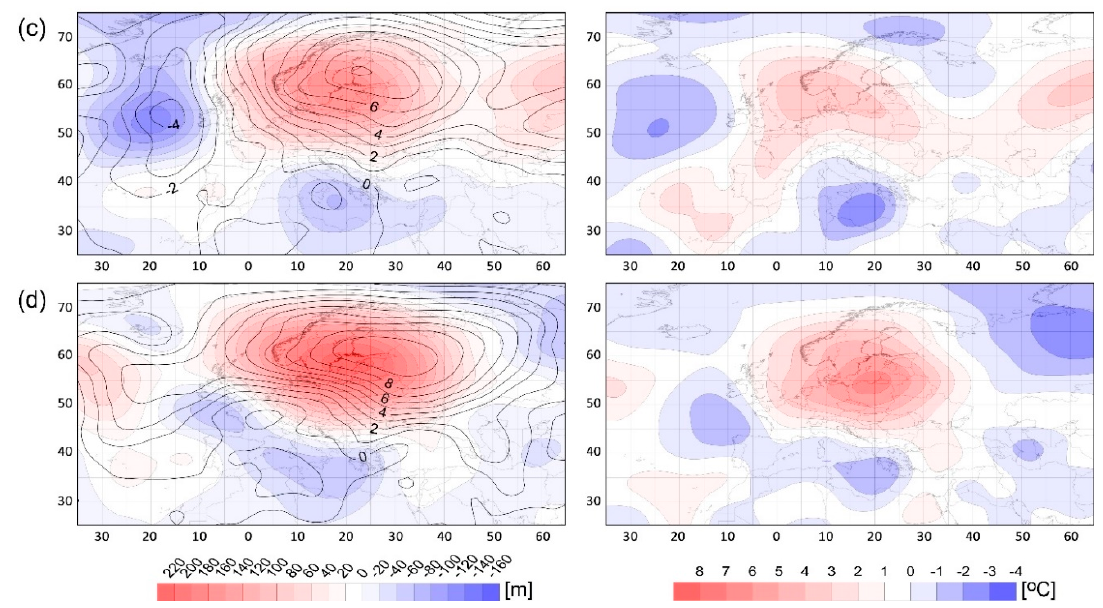
Figure 10. Mean anomalies of z300 hPa (colour shades) and SLP (black lines) (left column) and mean